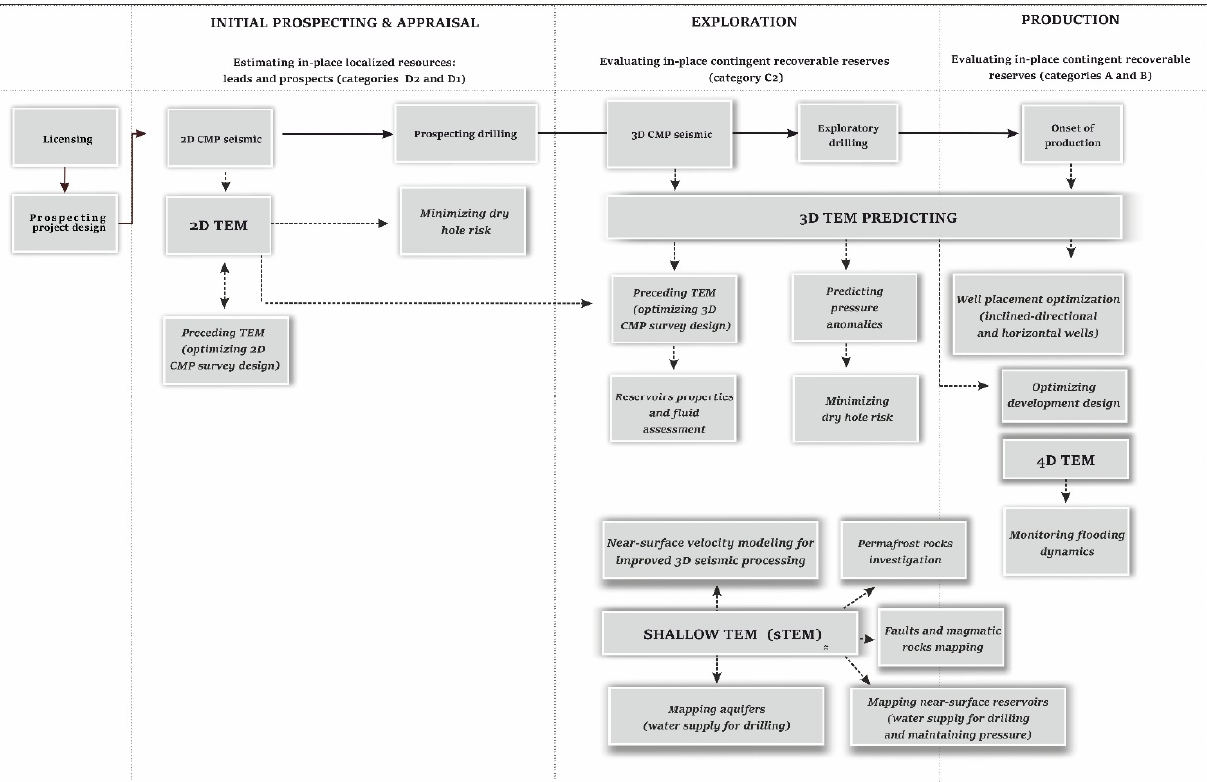
Figure 3. Workflow of seismic and TEM surveys, modified after